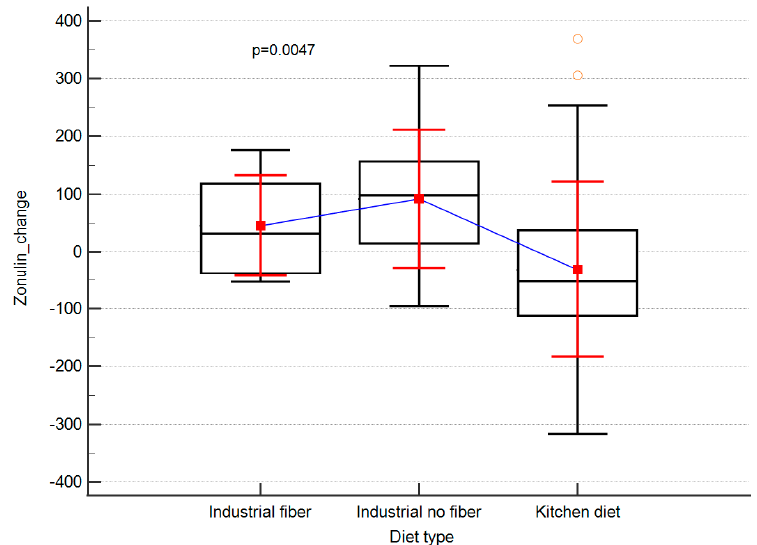
Figure 2. Effects of enteral diets on fecal zonulin release.